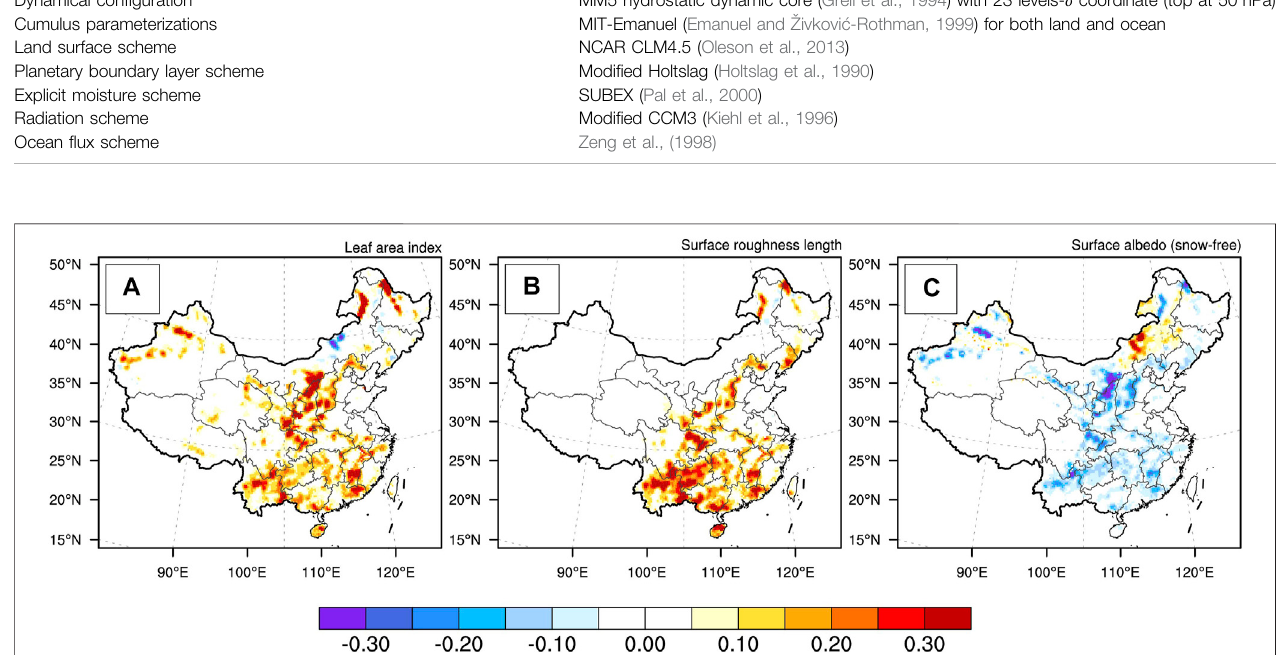
FIGURE 3 | The linear trends of various vegetation parameters during 1984 – 2013 in the TRANS experiment: (A) leaf area index, units: m 2 m − 2 /30a; (B) surface roughness length, units: m/30a; and (C) snow-free surface albedo, units: 10 − 1 /30a. All colored values in the plots are statistically signi fi cant at 95% con fi dence level.